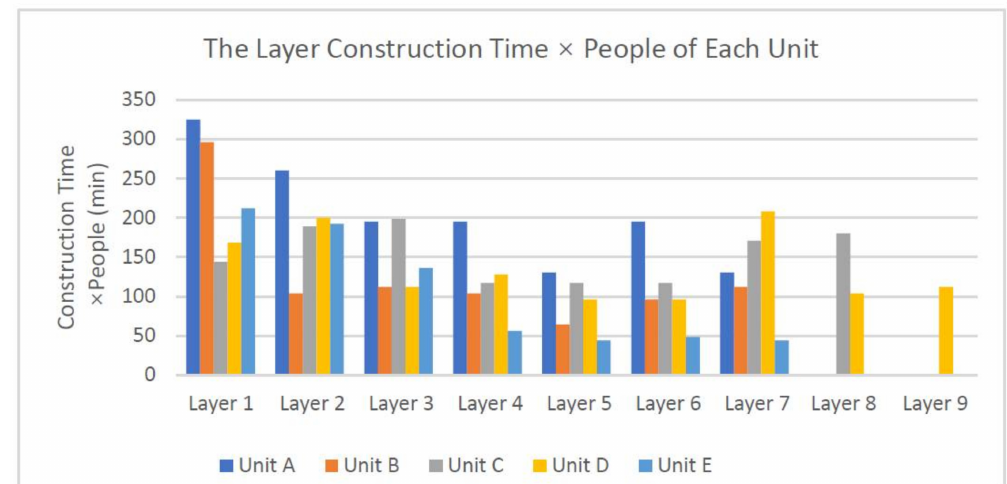
Figure 12. The layer construction time × people of each unit by manual construction.